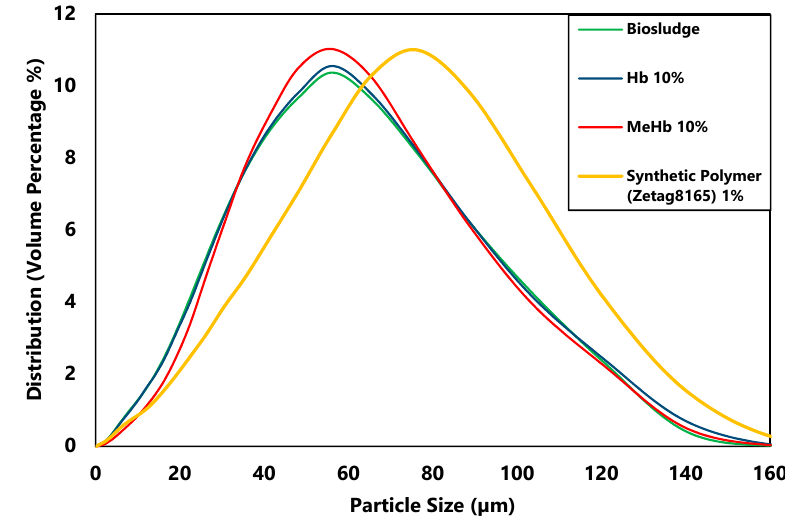
Figure 3. Particle size distribution of raw biosludge, conditioned biosludge with 10% of hemoglobin and methylated hemoglobin.